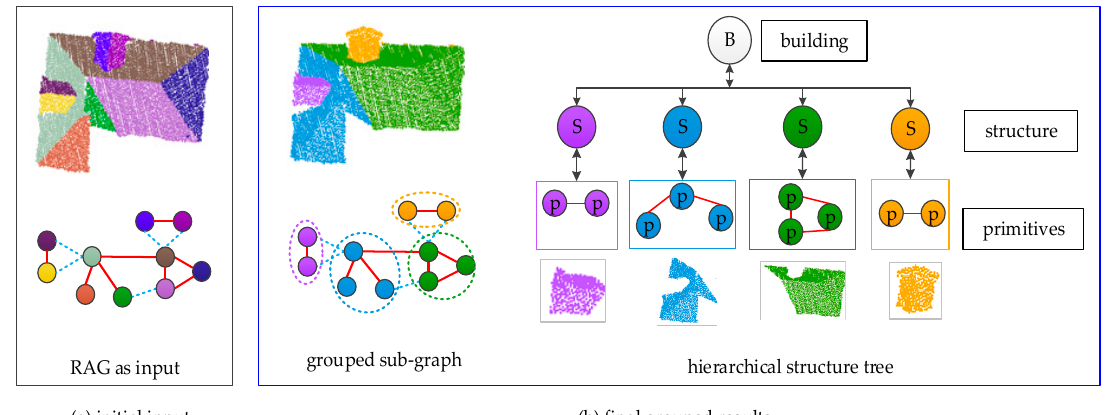
Figure 5. Overview of the progressive grouping based on Roof Attribute Graphs (RAG). ( a ) RAG as the input and planes are denoted by different colors; ( b ) individual grouped structures shown as sub-graphs are represented by different colors, corresponding to the planes grouped together.